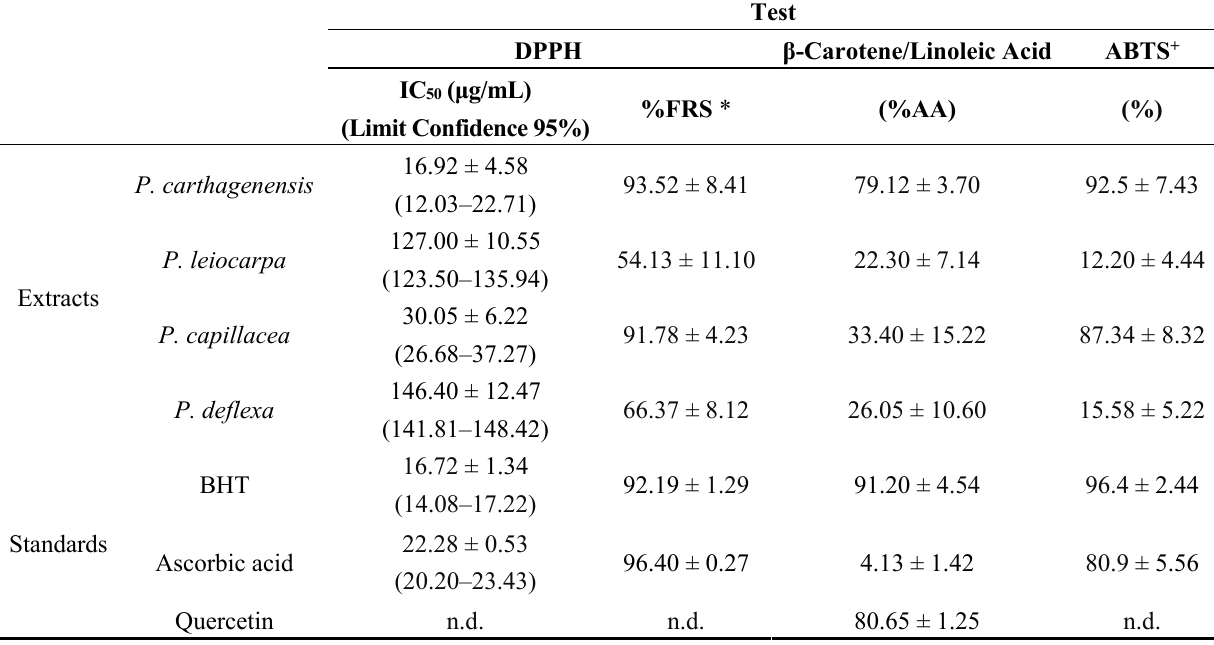
Table 1. Antioxidant activity of Psychotria leaf extracts by DPPH, β-carotene/linoleic acid and ABTS